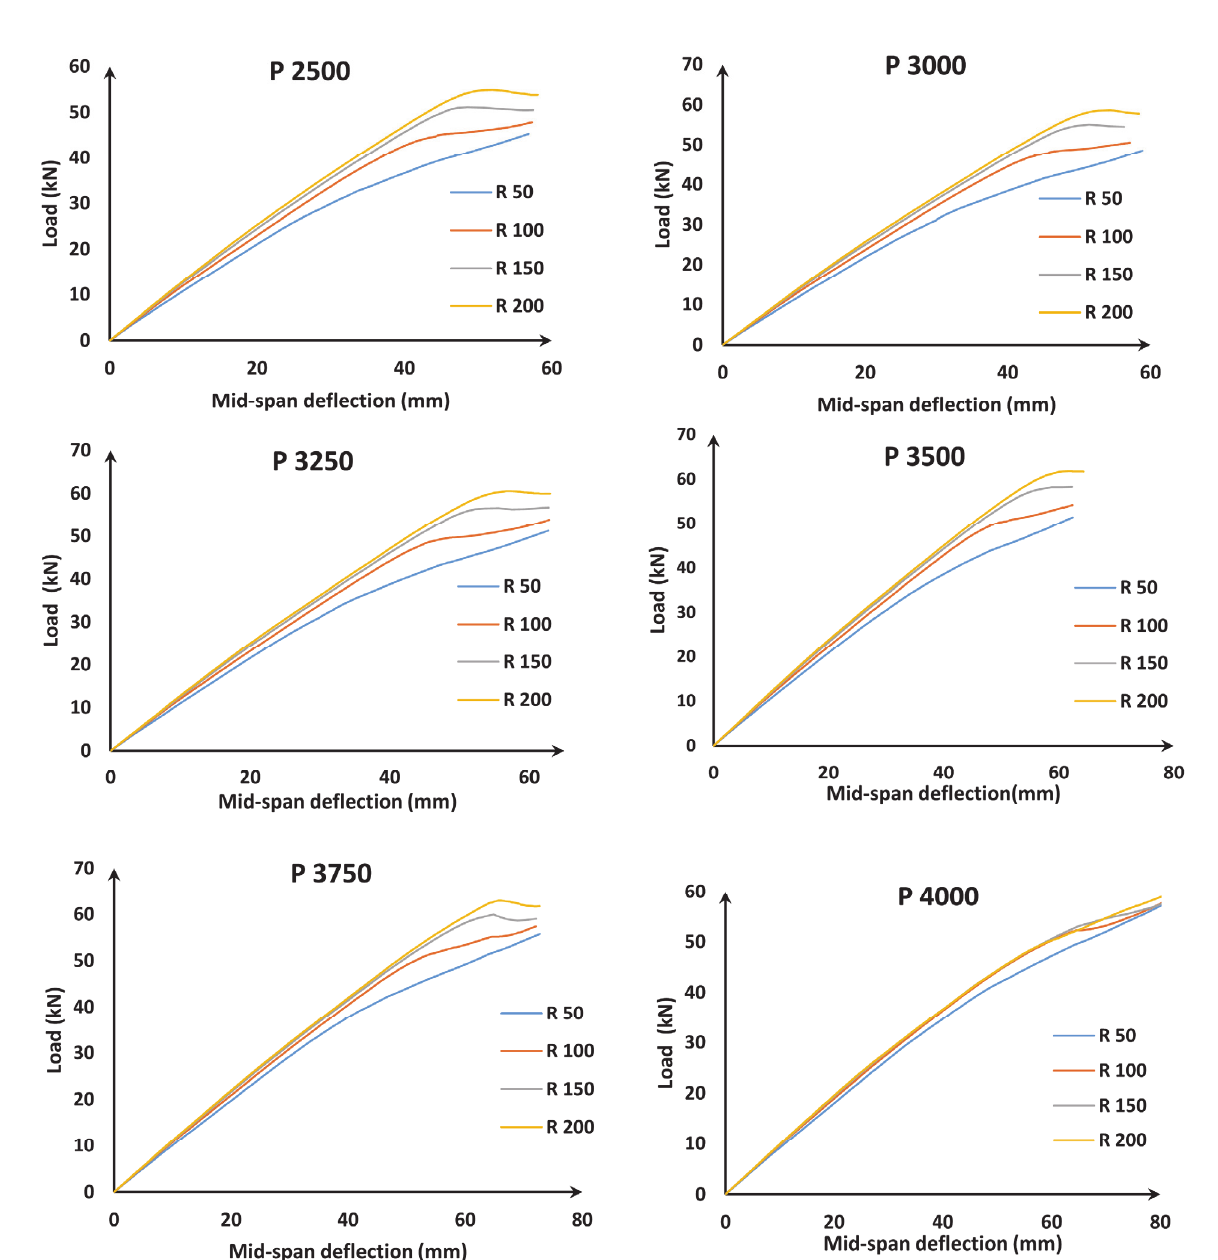
Figure 16: Load-mid-span curves of all bending cases of R50, R100, R150 and R200 in different